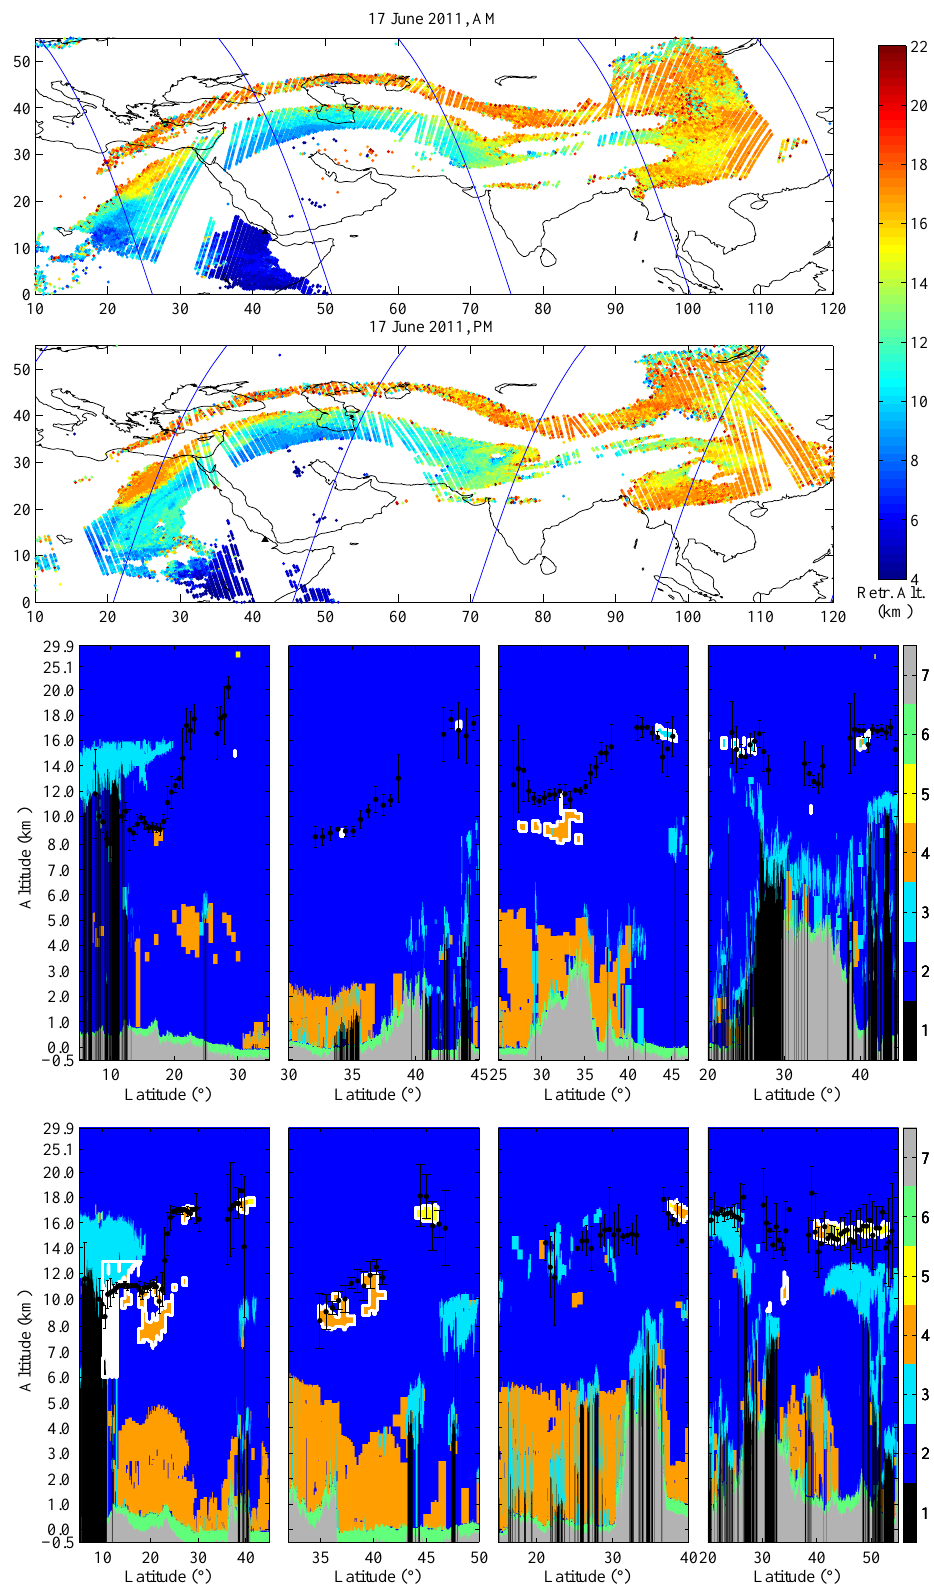
Fig. 8. Same as Fig. 6 for 17 June